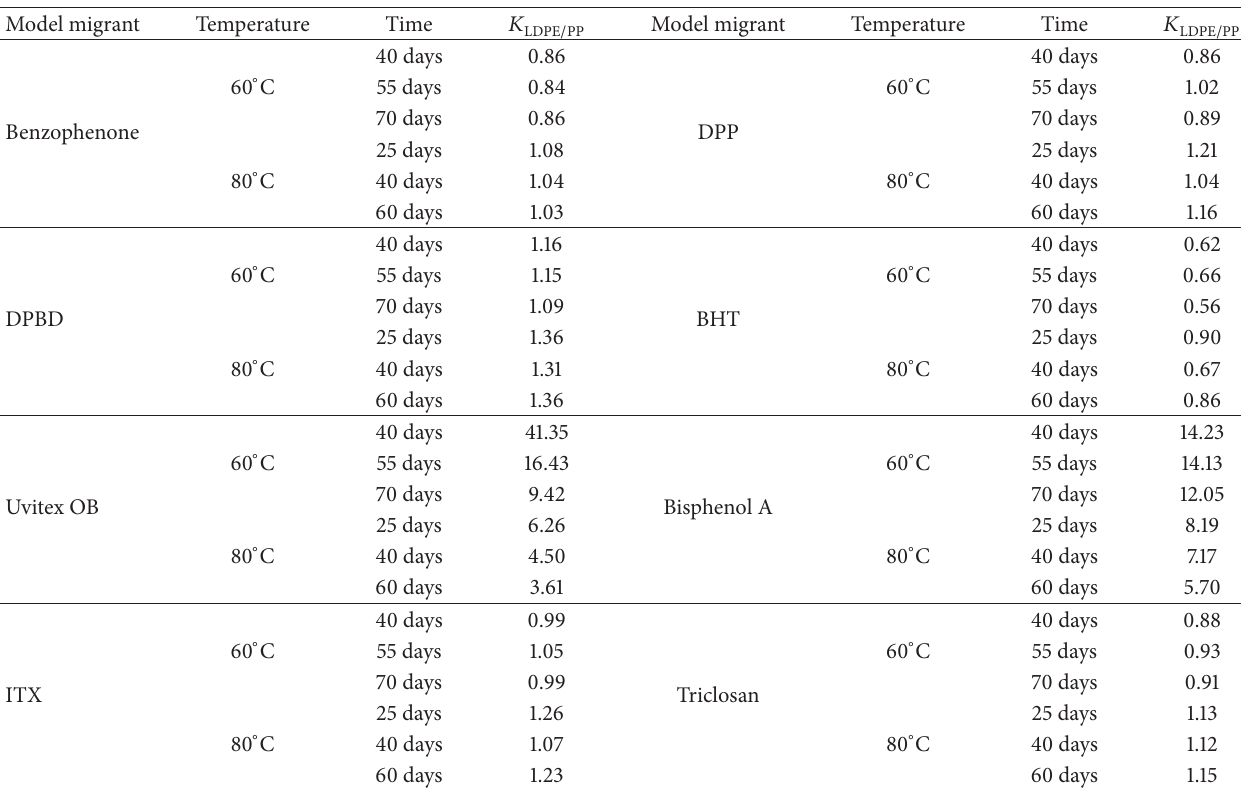
Table 5: Partition coefficient of polyethylene/polypropylene ( 𝐾 LDPE / PP ) at 60 ∘ C and 80 ∘ C for all substances studied. Model